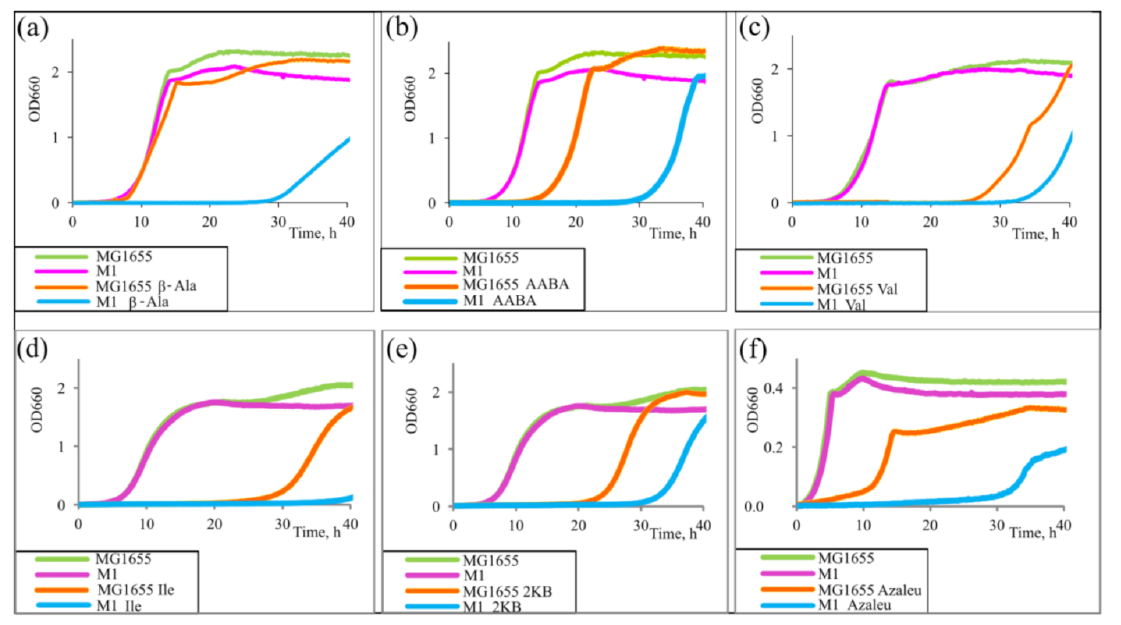
Figure 2. Growth inhibition assay. Strains E. coli K12 MG1655 and M1 (MG1655 cat -P L - cycA ) were incubated in parallel in minimal medium (M9) containing ( a ) 50 mg/L β -alanine ( β -Ala), ( b ) 50 mg/L α -aminobutyrate (AABA), ( c ) 0.5 mg/L valine (Val), ( d ) 15 g/L isoleucine (Ile), ( e ) 150 mg/L α - ketobutyrate (2KB), or ( f ) 500 mg/L azaleucine (Azaleu) at 37 ◦ C for 40 h or without additions as a control. The data are the mean values of three replicates.